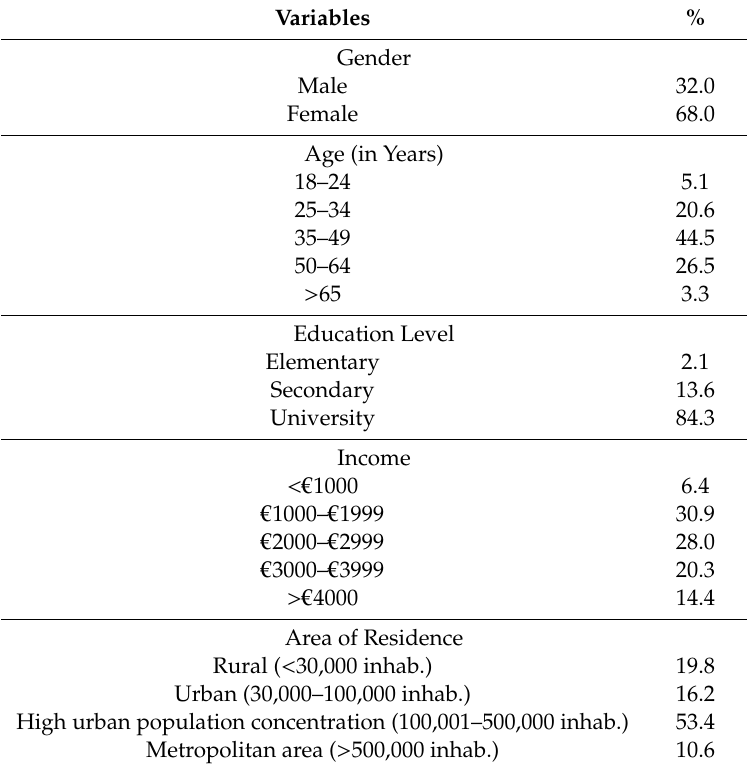
Table 1. Socio-economic characteristics of the sample of people who are in charge of